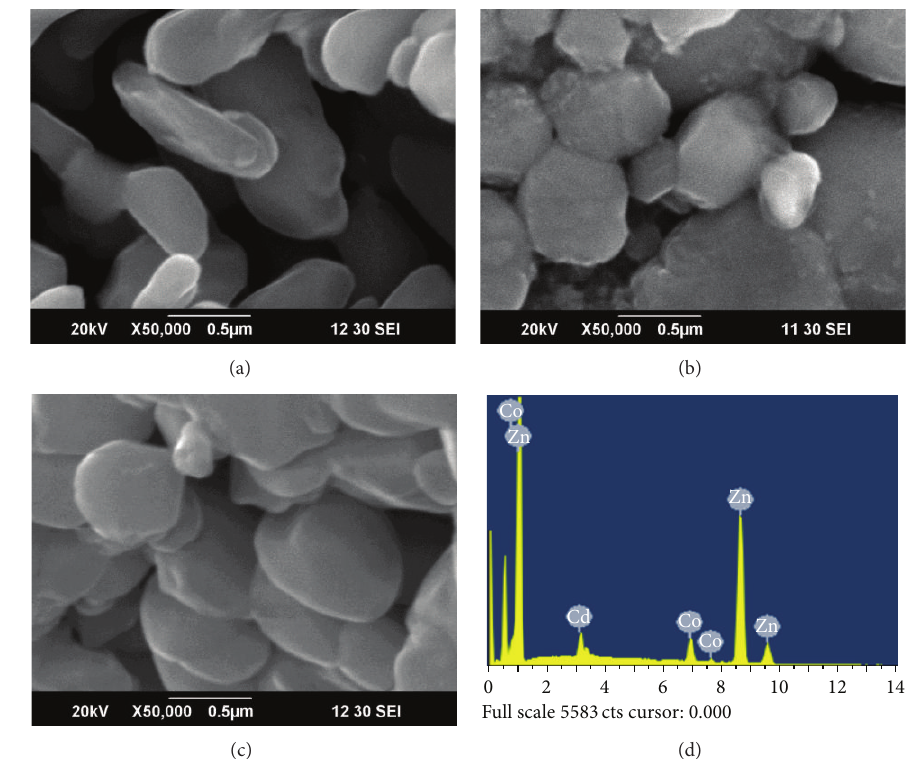
Figure 5: SEM micrographs of (a) Zn 0.9 Co 0.1 O, (b) Zn 0.9 Co 0.06 Cd 0.04 O, (c) Zn 0.9 Cd 0.1 O, and (d) EDX of Zn 0.9 Co 0.06 Cd 0.04 O. lattice parameter shows greater (Co, Cd ⋅ ⋅ ⋅ Co, Cd) distances, which will ultimately influence their magnetic interactions and cause lowering of